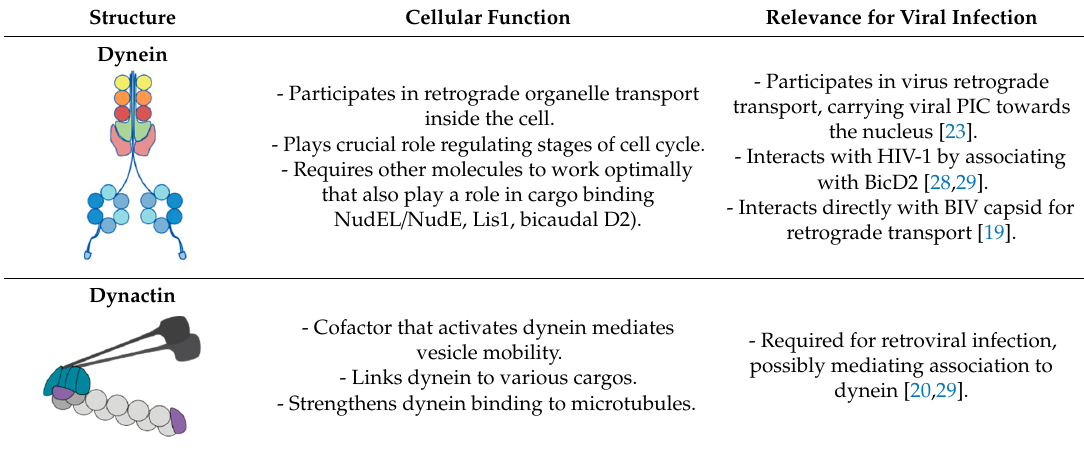
Table 1. Motor proteins and their roles on viral infection.